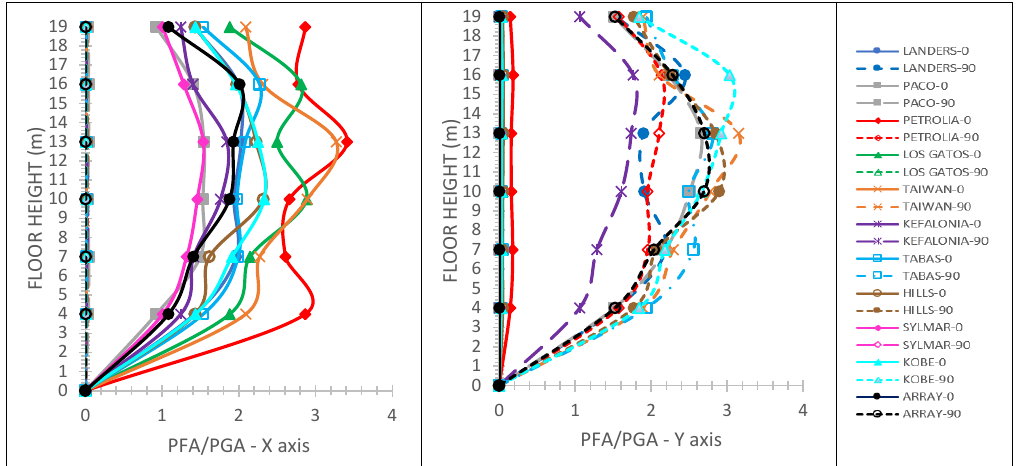
Figure 21. PFA/PGA along X ( left ) and Y ( right ) horizontal directions of the six-story mixed building, considering the fixed connection of the steel structure to the r/c one.